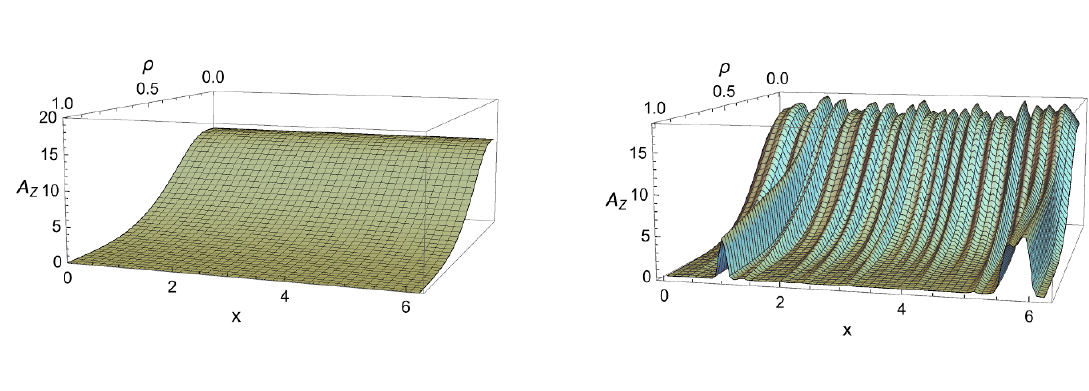
Figure 6 . A concrete con(cid:12)guration of the gauge (cid:12)eld along the bulk for T=M = 1 = (10 (cid:25) ), (cid:22) b 0 = 1 : 35 and (cid:22) (cid:13) = 0 ; 0 : 002 (left, right). were the \critical exponent" is found to be (cid:23) = 0 : 673. This is a clear signature of the presence of scale invariance inside the quantum critical